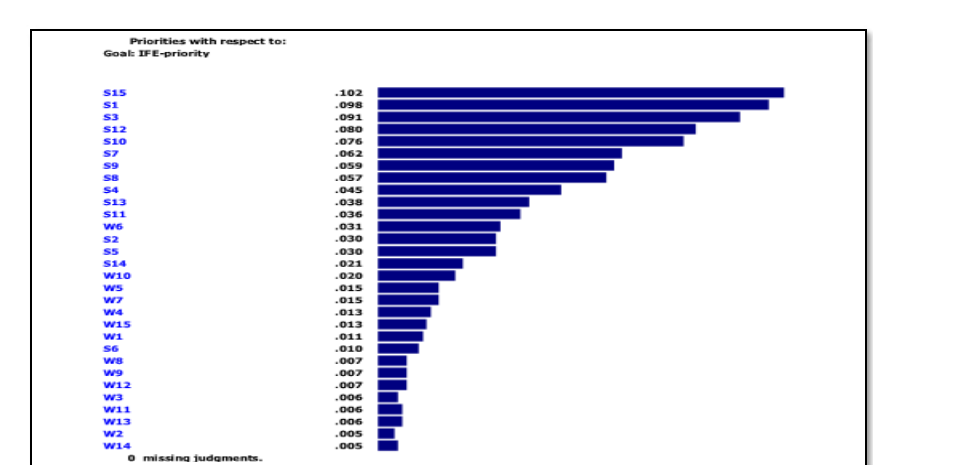
Fig. 4: Internal factors of existing environment by AHP and EC